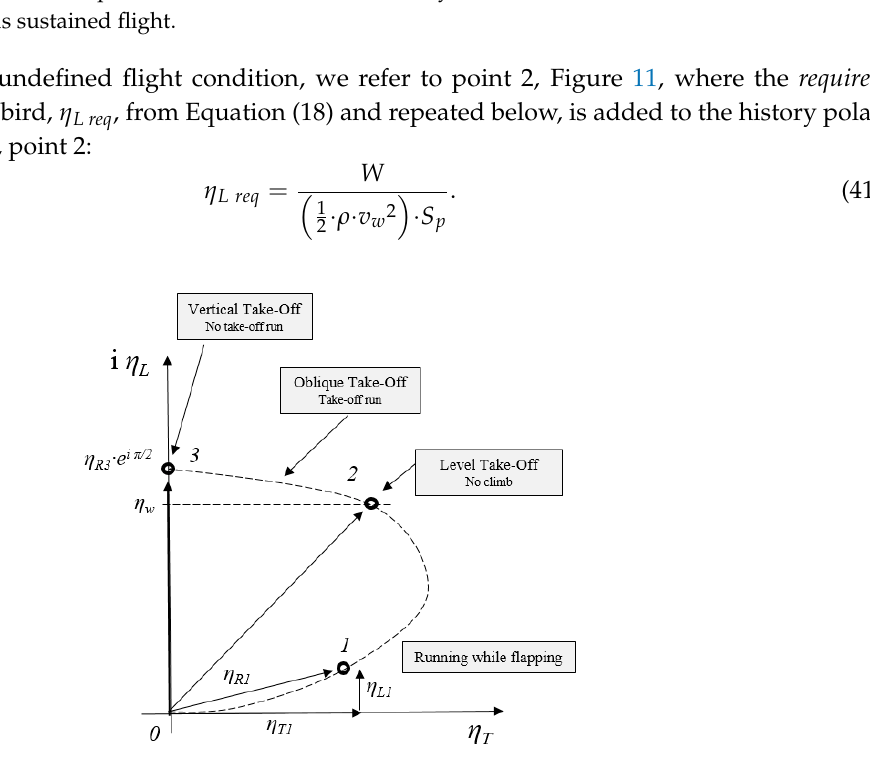
Figure 10. A hypothetical polar that describes the take-off by an extant bird and the evolution of a protobird towards sustained flight. protobird towards sustained flight.